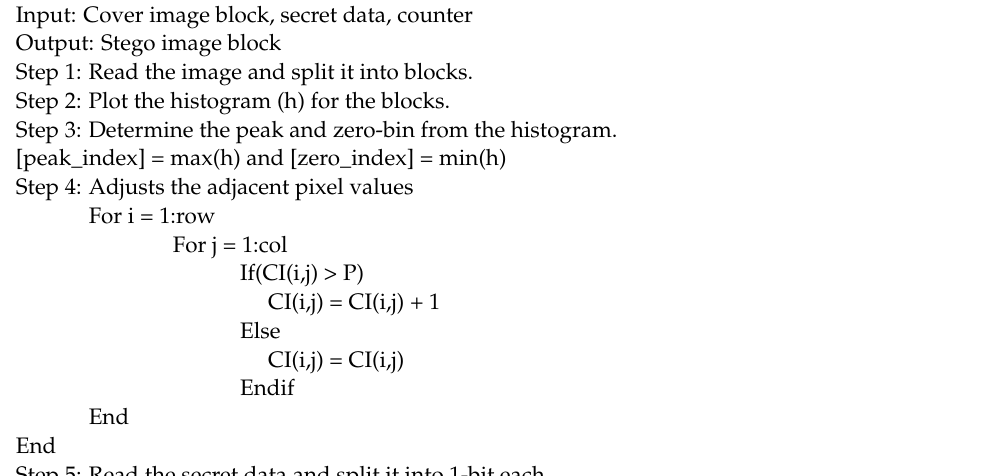
Algorithm 1: Pseudocode for the proposed